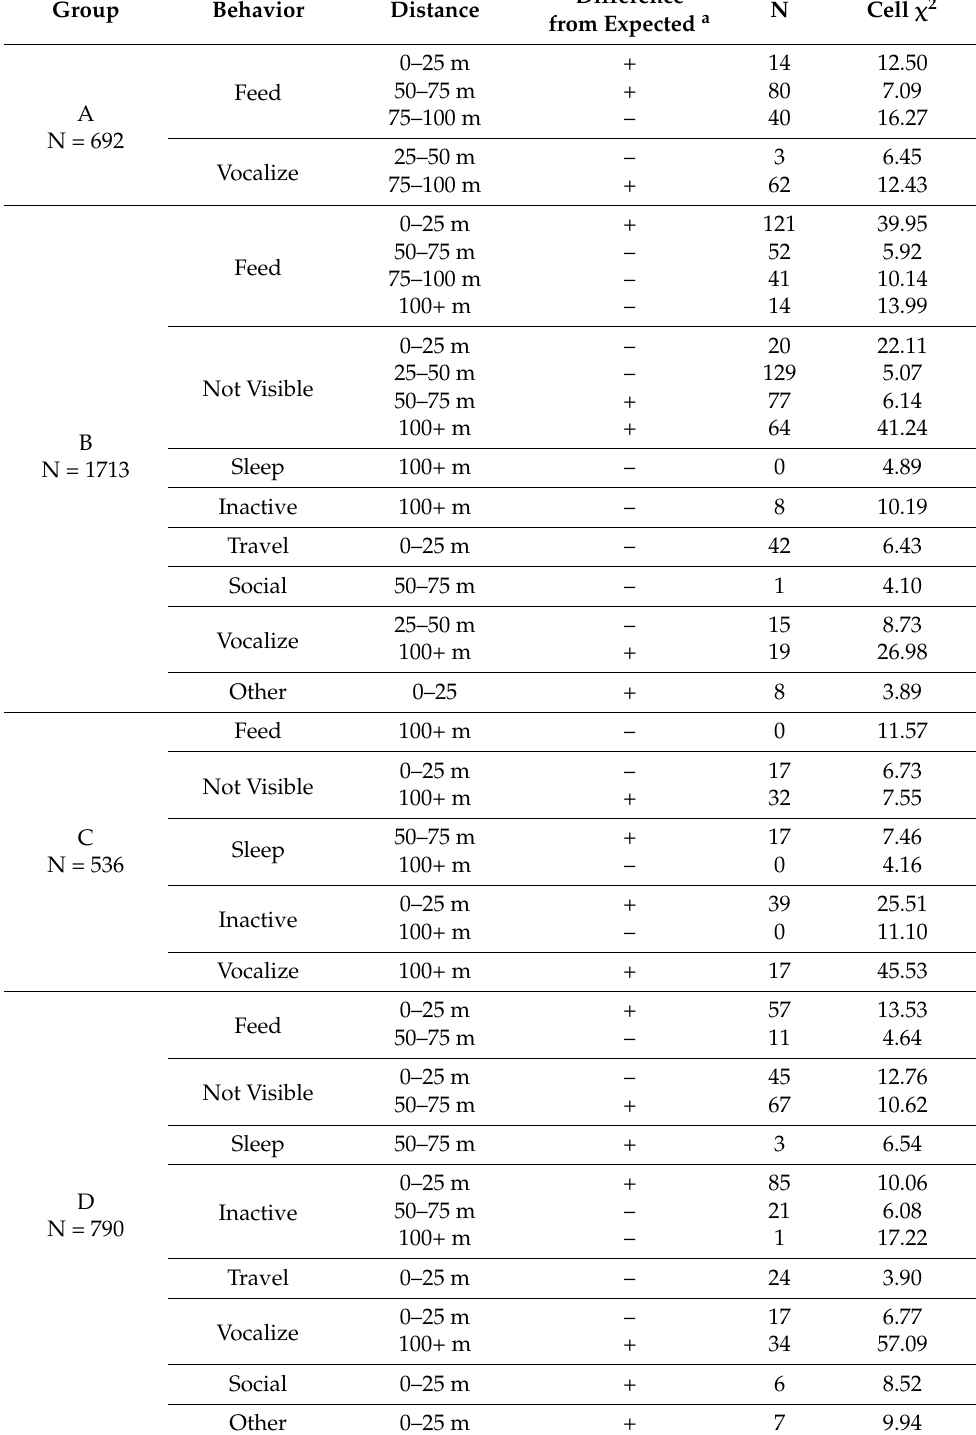
Table 2. Behavioral changes at varying distances from one human